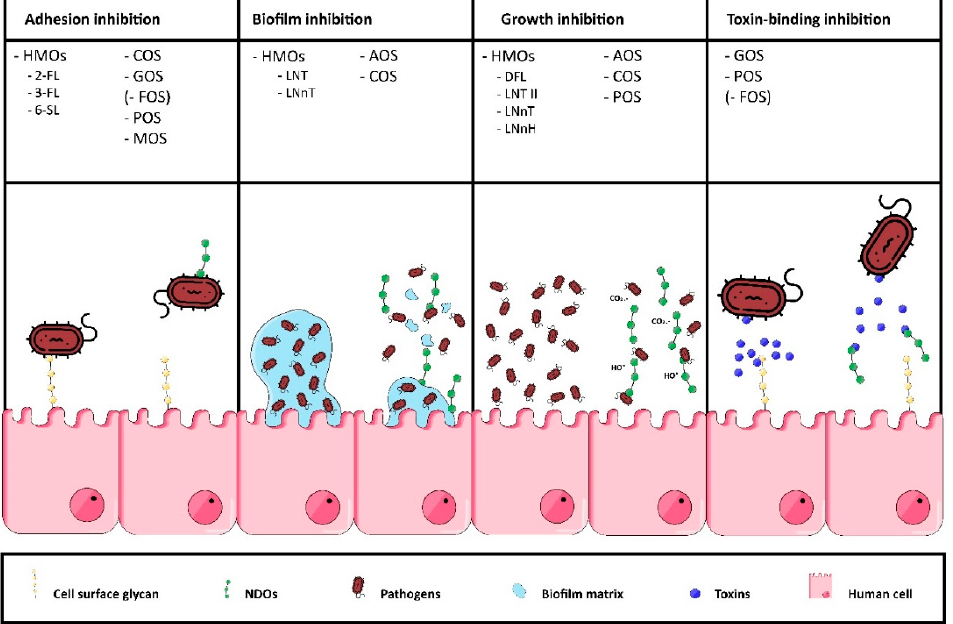
Figure 8. Schematic overview of the anti-pathogenic functionalities of NDOs in vitro. The first column shows that different NDOs (different HMOs, COS, GOS, FOS, POS and MOS) can serve as decoy receptors that competitively bind pathogens, which prevents pathogen adhesion to cell surface glycans. The second column indicates that several HMOs, AOS and COS can inhibit biofilm formation by penetrating and interacting with elements of the pathogenic biofilm. Multiple NDOs, such as, different HMOs, AOS, COS and POS, have shown to inhibit pathogenic growth, for example, by disrupting the bacterial cell membrane and/or by scavenging free radicals, such as HO•, which have a number of pathological effects (third column). The fourth column indicates that several NDOs (GOS, POS, FOS) can inhibit host cell interaction with pathogenic toxins.